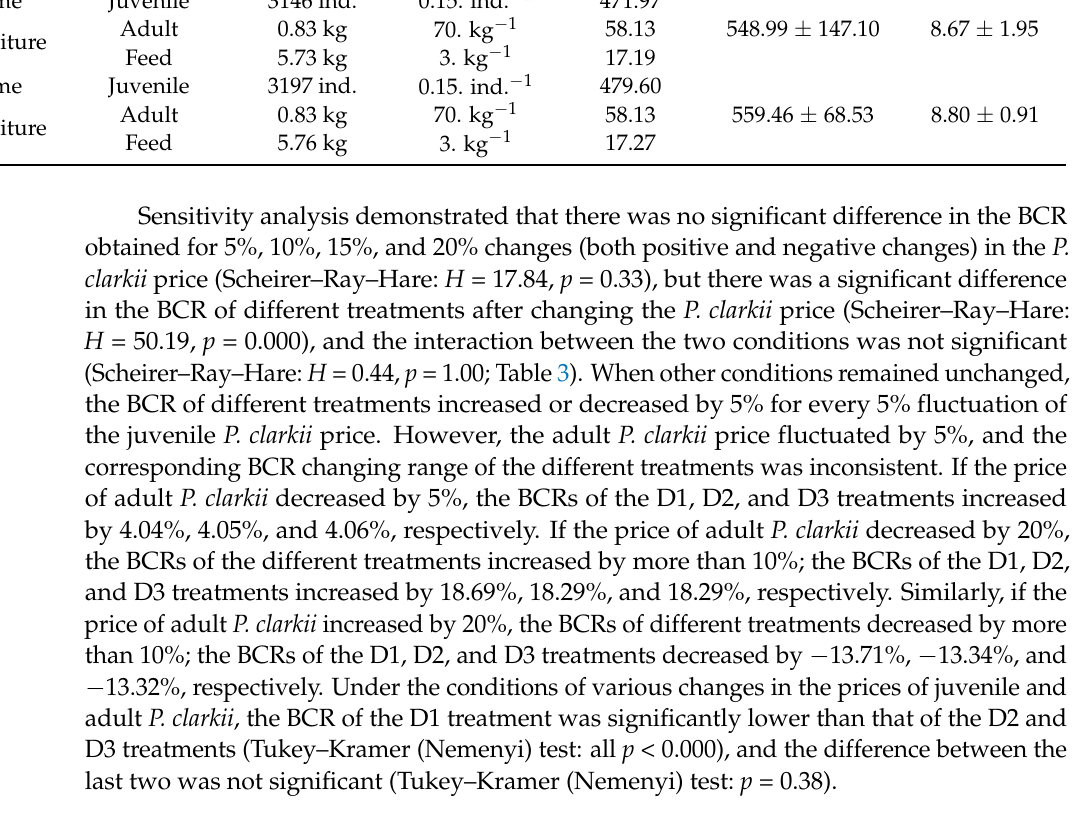
Table 2. The economic benefits (gross profit and BCR; mean ± SE) of breeding P. clarkii at different shelter treatments.